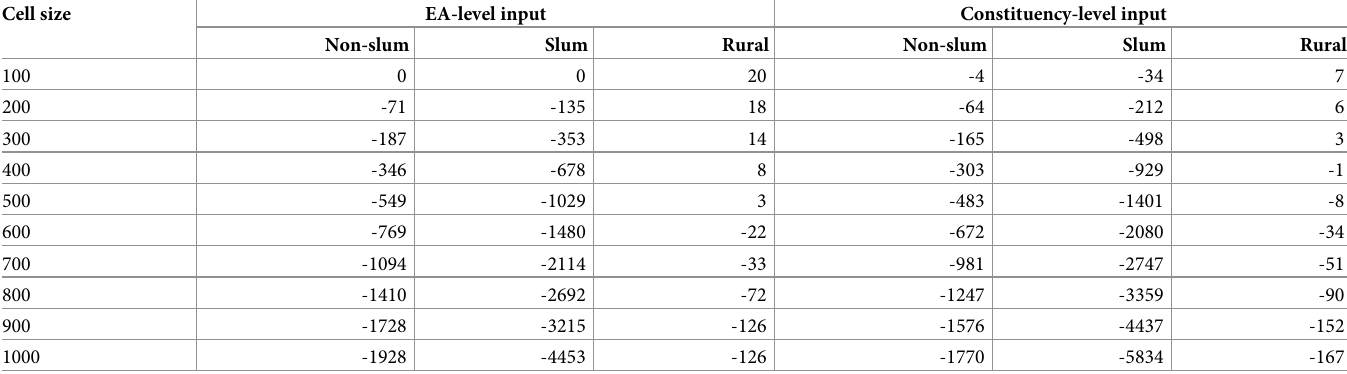
Table 4. Bias in gridded population estimates derived from “true” synthetic population counts, by output grid cell size and urban/rural location (in cells > = 1 esti- mated person).